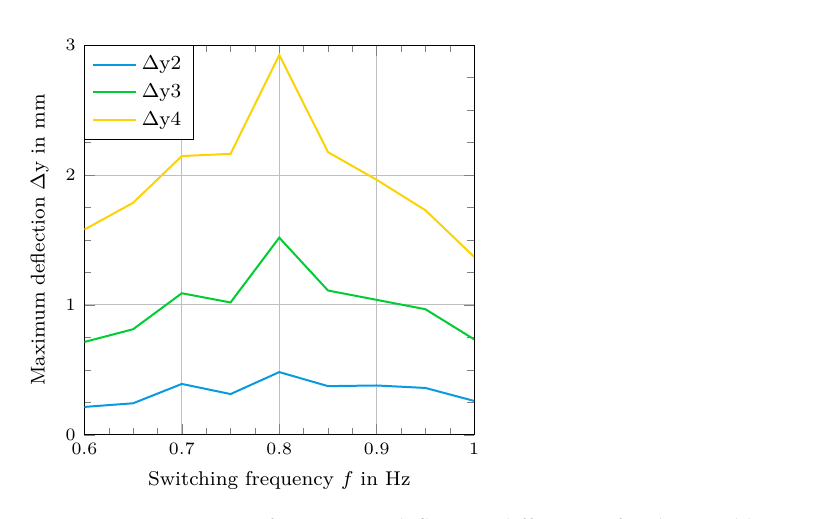
Figure 9. Comparison of maximum deflection differences for the speckle patterns at P2–P4 from Figure 4 for different switching frequencies at the driving voltage of 3000 V.